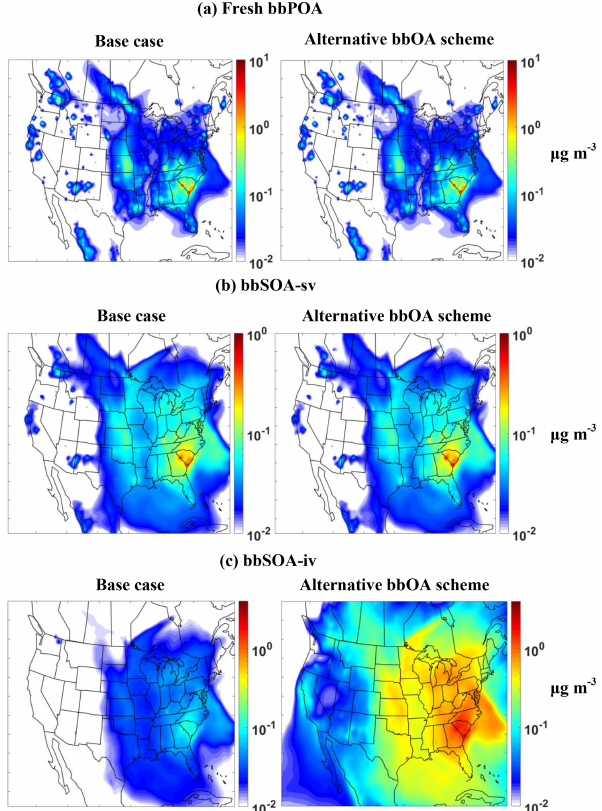
Figure 1. PMCAMx-SR-predicted ground-level concentrations of (a) fresh bbPOA, (b) SV-bbSOA-sv, and (c) SV-bbSOA-iv from all biomass burning sources during April 2008. Left column refers to the base case simulations and right column to the simulations with the alternative bbOA scheme. All concentrations are in µgm − 3